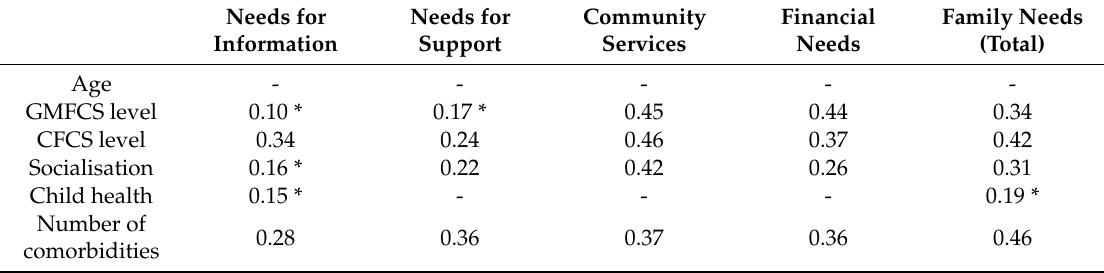
Table 8. Statistically significant correlations between family needs and child’s characteristics. Needs for Needs for Information Support